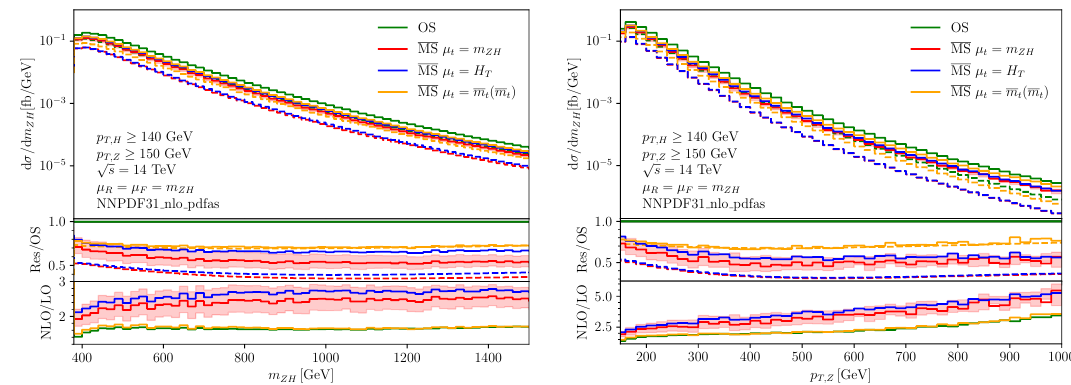
Figure 8. Comparison of differential results using various top quark mass schemes at LO (dashed) and NLO (solid). Left: invariant mass. Right: Z -boson transverse